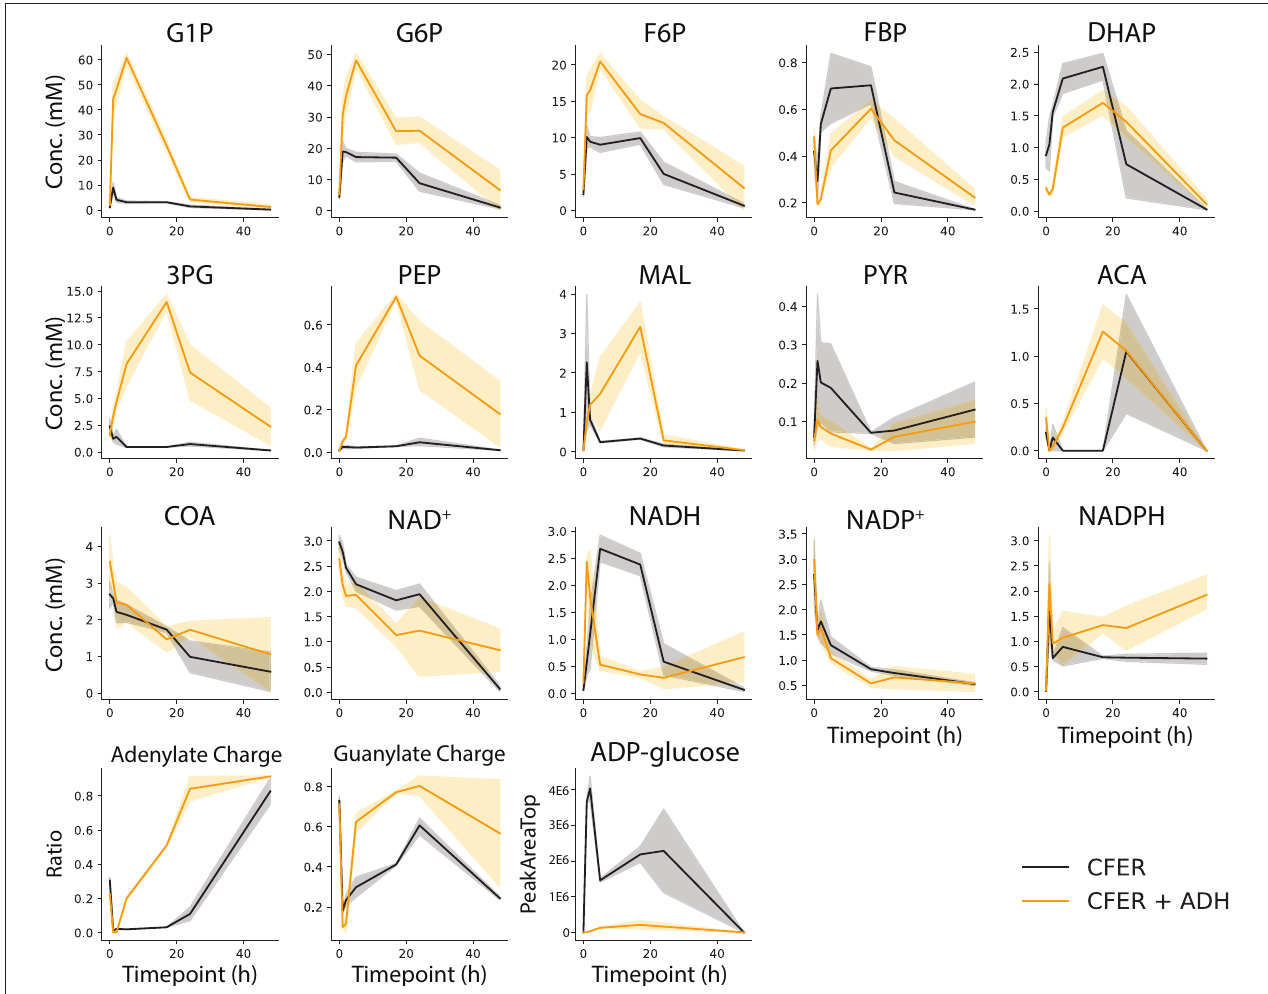
FIGURE 6 | Intermediate metabolite concentrations in the CFER. Samples were taken from the CFER at 1, 2, 5, 17, 24, and 48h and quenched by filtration. External standards were used to quantify each metabolite. The abbreviations used are listed in Figure 1 . Energy charge was calculated by (NTP + 0.5 NDP)/(NTP + NDP + NMP), N is A or G. Black lines represent CFER with no additional enzymes, orange lines represent CFER with addition of yeast alcohol dehydrogenase (ADH) enzyme. Solid lines represent average concentration (or ratio) from four replicates, and the shaded band around the lines represents the 95% confidence interval from four replicates. Raw data included in Supplementary Table 8